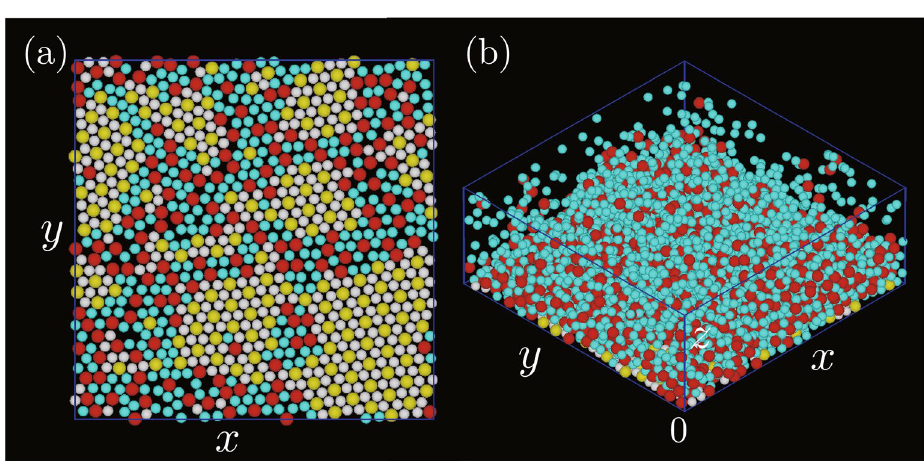
Figure 7. ( a ) Two-dimensional structure on the bottom wall and ( b ) Three-dimensional view for ε AA /ε AB = ε BB /ε AB = 0.1 for ρ = 0.2